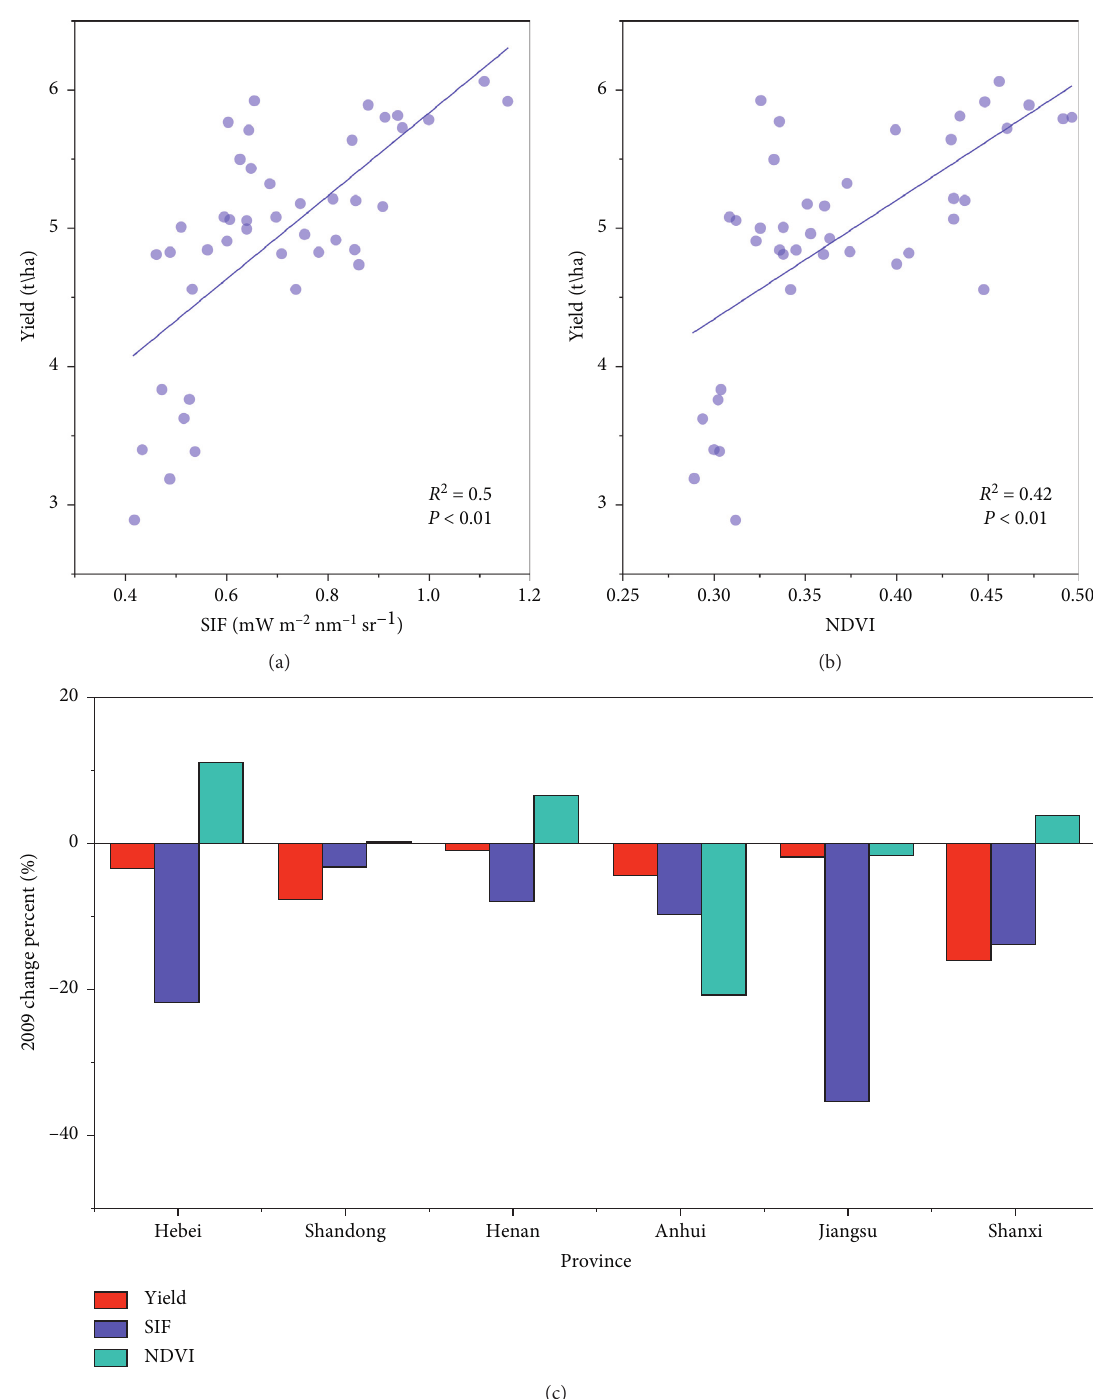
Figure 8: Comparison of wheat yield and wheat growing season mean (a) SIF and (b) NDVI over the whole study region at the province scale. (c) Percent of change in yield/SIF/NDVI compared with 2008–2014 multiyear values in the 2009 heat wave